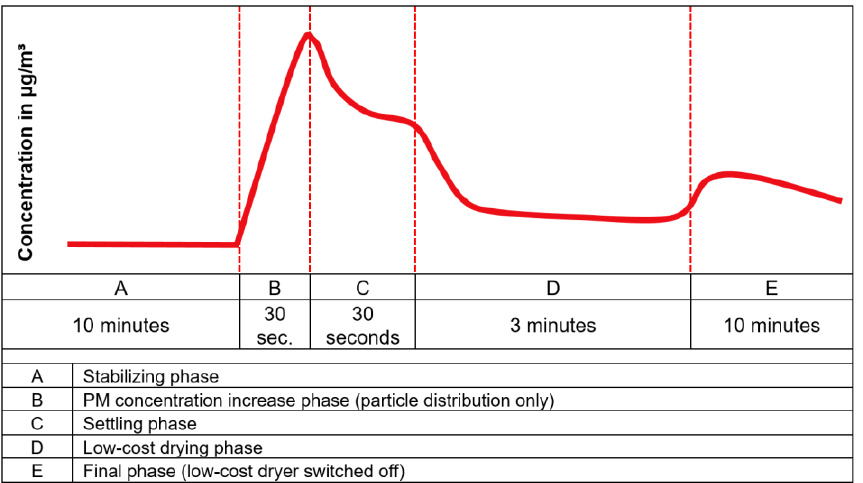
Figure 8. Temporal variation of an ideal PM concentration curve using synthetic dust only.